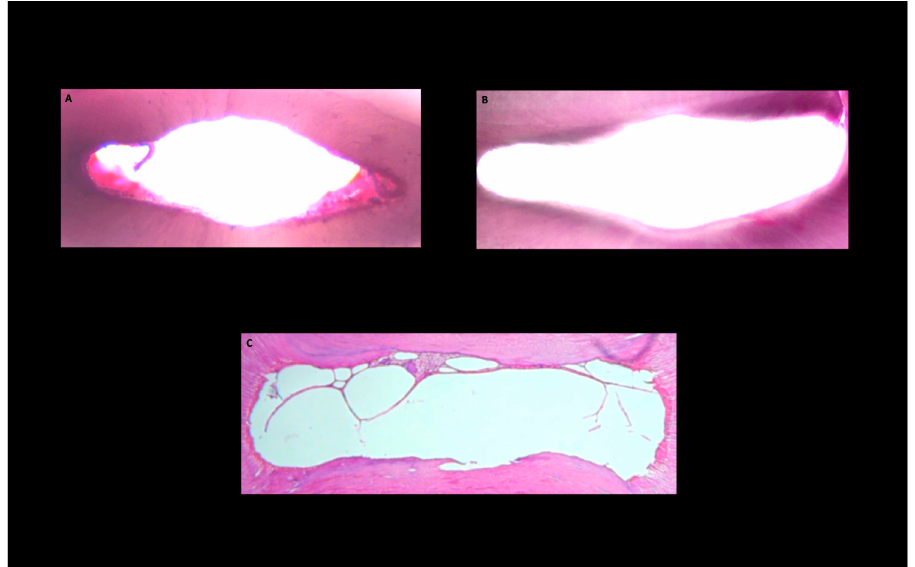
Figure 1. Histological images of the cross-sections obtained from the middle third of the root canal area after root canal preparation. Pulp tissue and microbial biofilm debris persisting and root canal wall protruding into the canal lumen (white) in ultrasonically activated (group A ), ultrasonically activated preceded by intracanal heating (group B ) and traditionally applied (group C ) NaOCl groups.